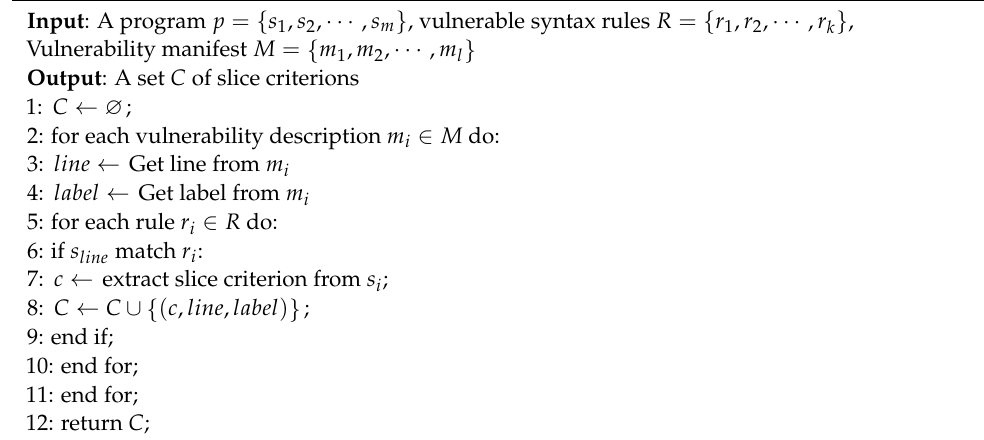
Algorithm 1. Extracting security-sensitive operations from a